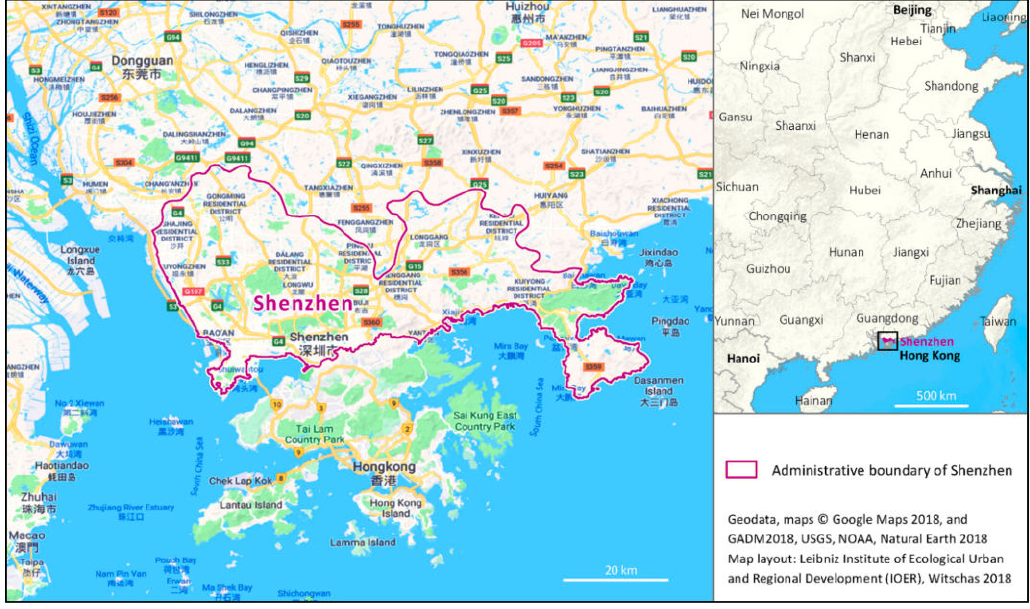
Figure 1. Location of the case study city